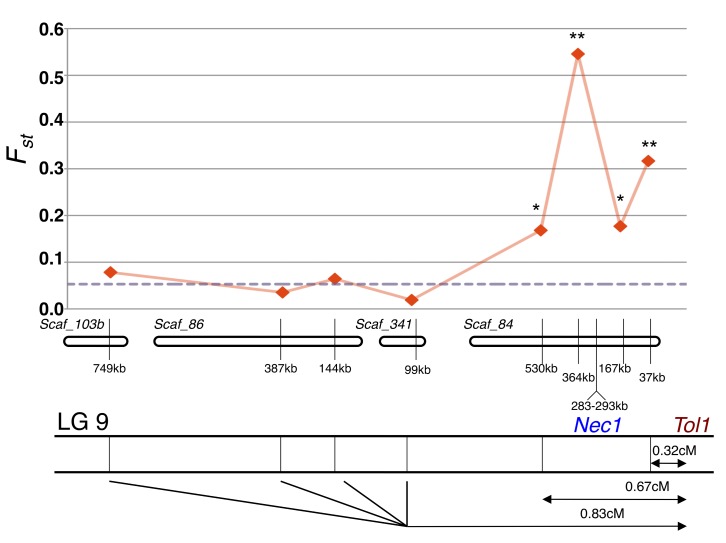

Fst of Tol1Link markers.
Fst values for Tol1Link markers distributed along LG 9. Dashed line is mean Fst for Tol1UnLink dataset. * p<0.025. ** p<0.0025.